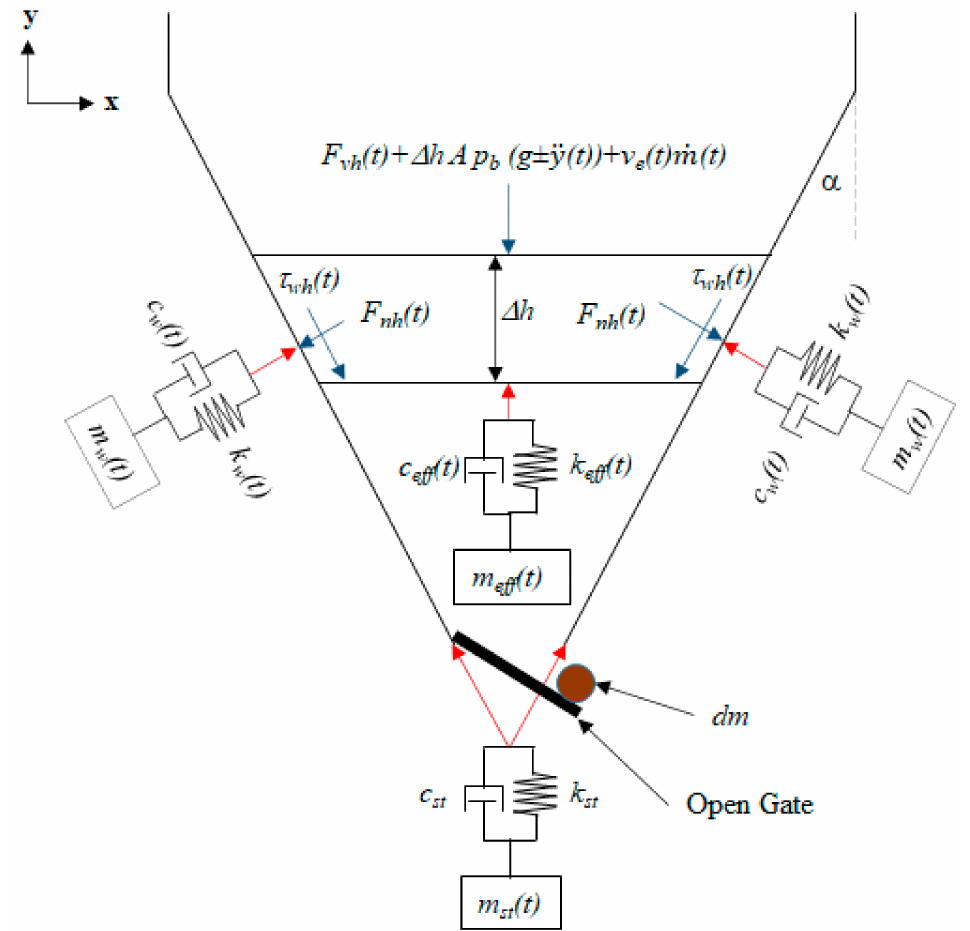
Figure 3. Graphical illustration of Equation (1) for a converging wall